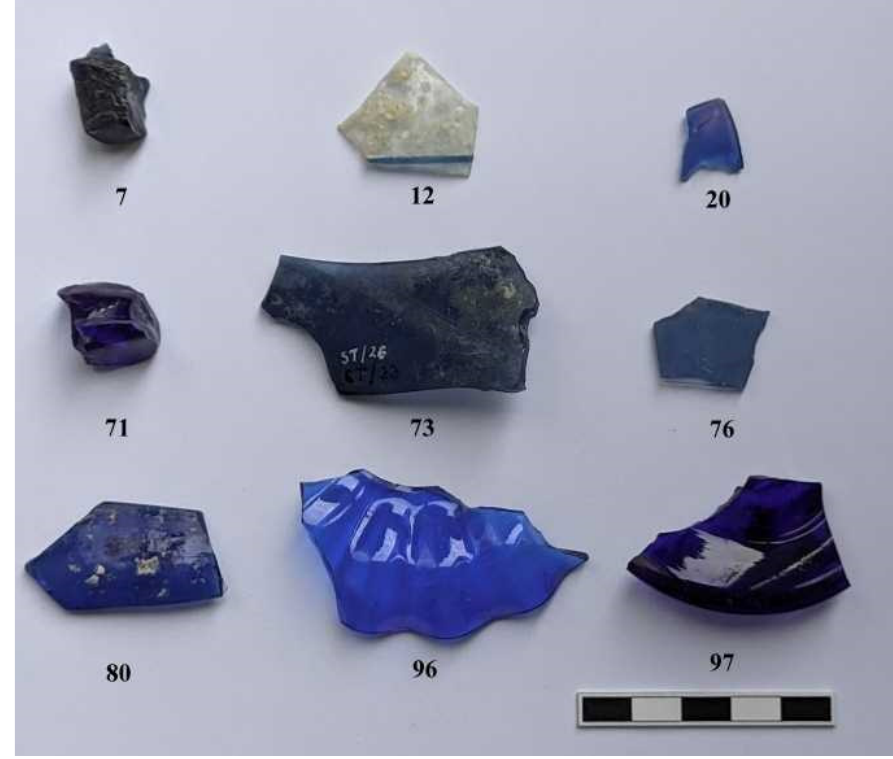
Figure 1. Selection of examples of blue fragments and glassworking waste. The fragments are organized chronologically.